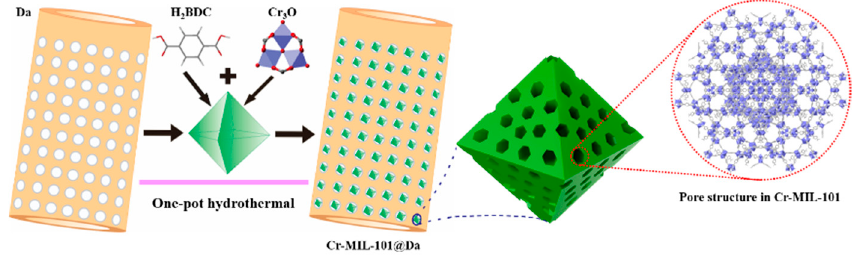
Figure 2. Schematic illustration of the construction of Cr-MIL-101@Da.